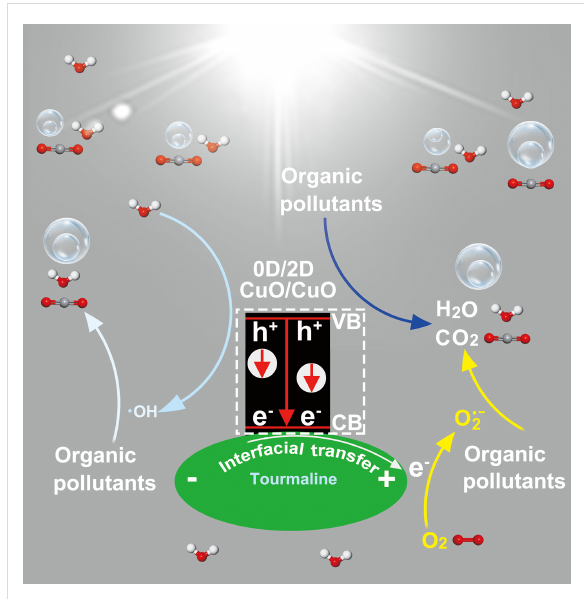
With a combination of the analyses carried out above, a plau- sible mechanism for strengthening the photocatalytic degrada- tion activity of CuO with tourmaline was proposed and shown in Figure 9. The e − in the valence band (VB) of CuO